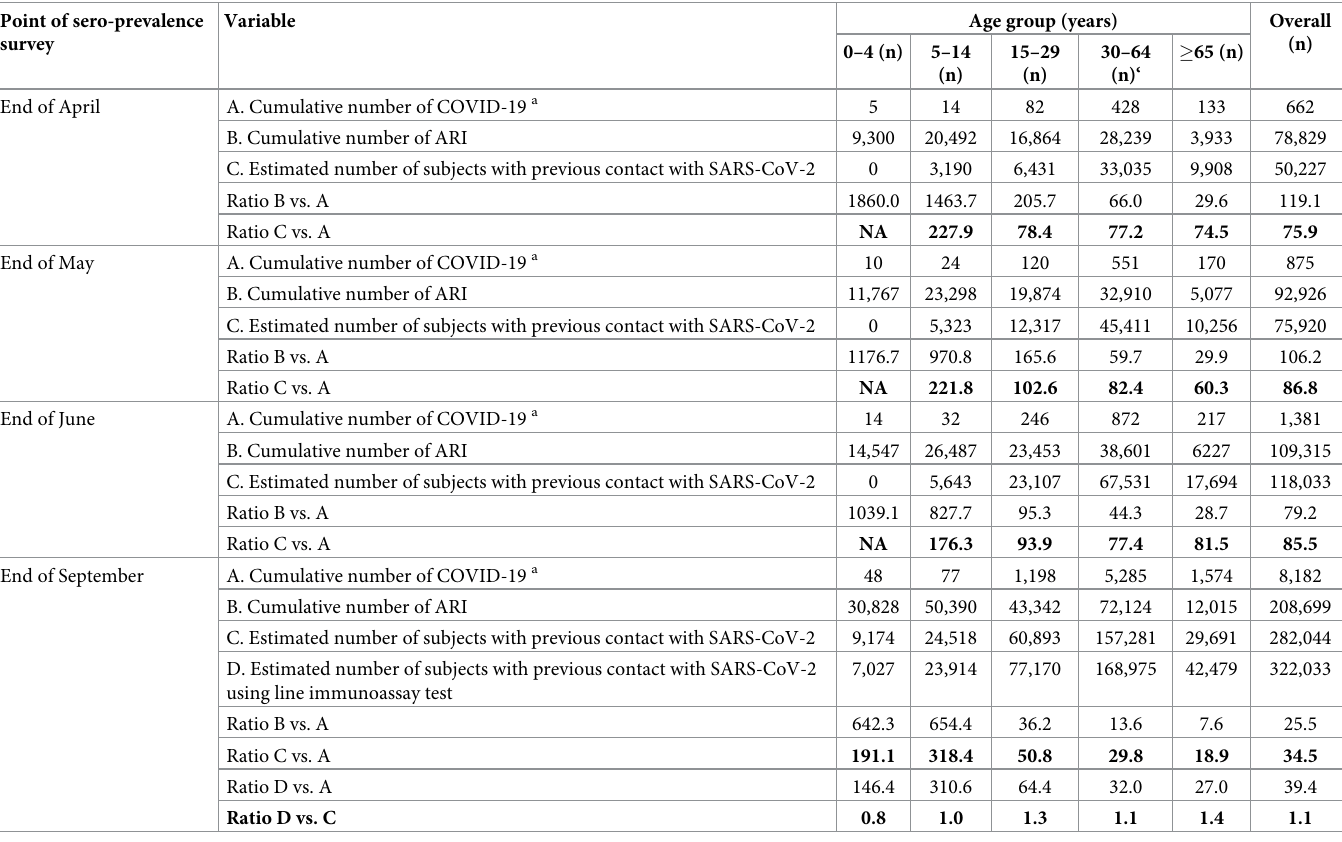
Table 2. Cumulative and estimated number of COVID-19 and acute respiratory infection cases and their ratio between April and September, 2020 using Point-of- care test and Line immunoassay test in Vojvodina, Serbia. Point of sero-prevalence